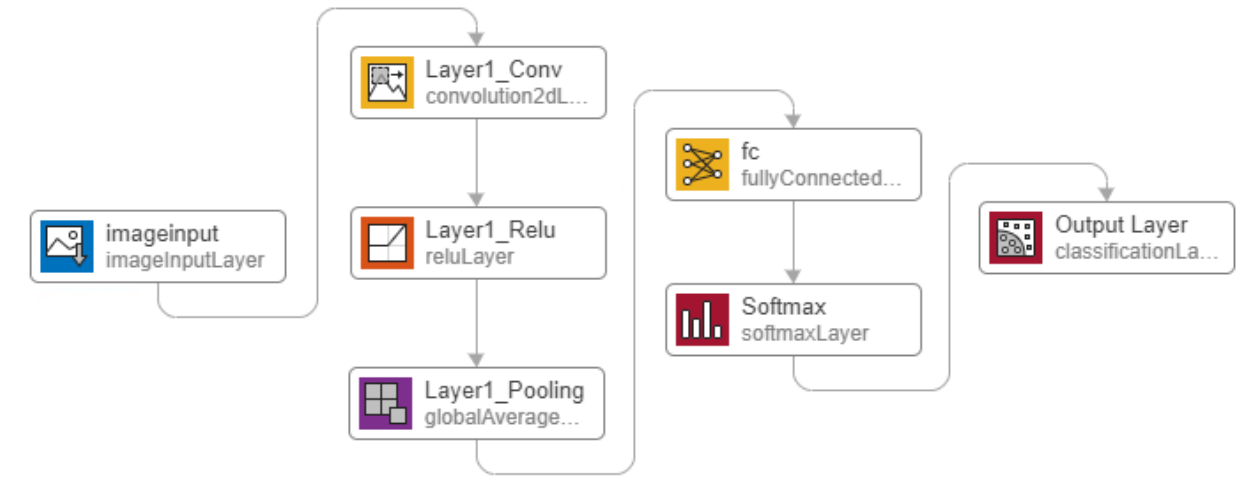
Figure 6. Proposed 2-D Convolutional Neural Network (CNN)